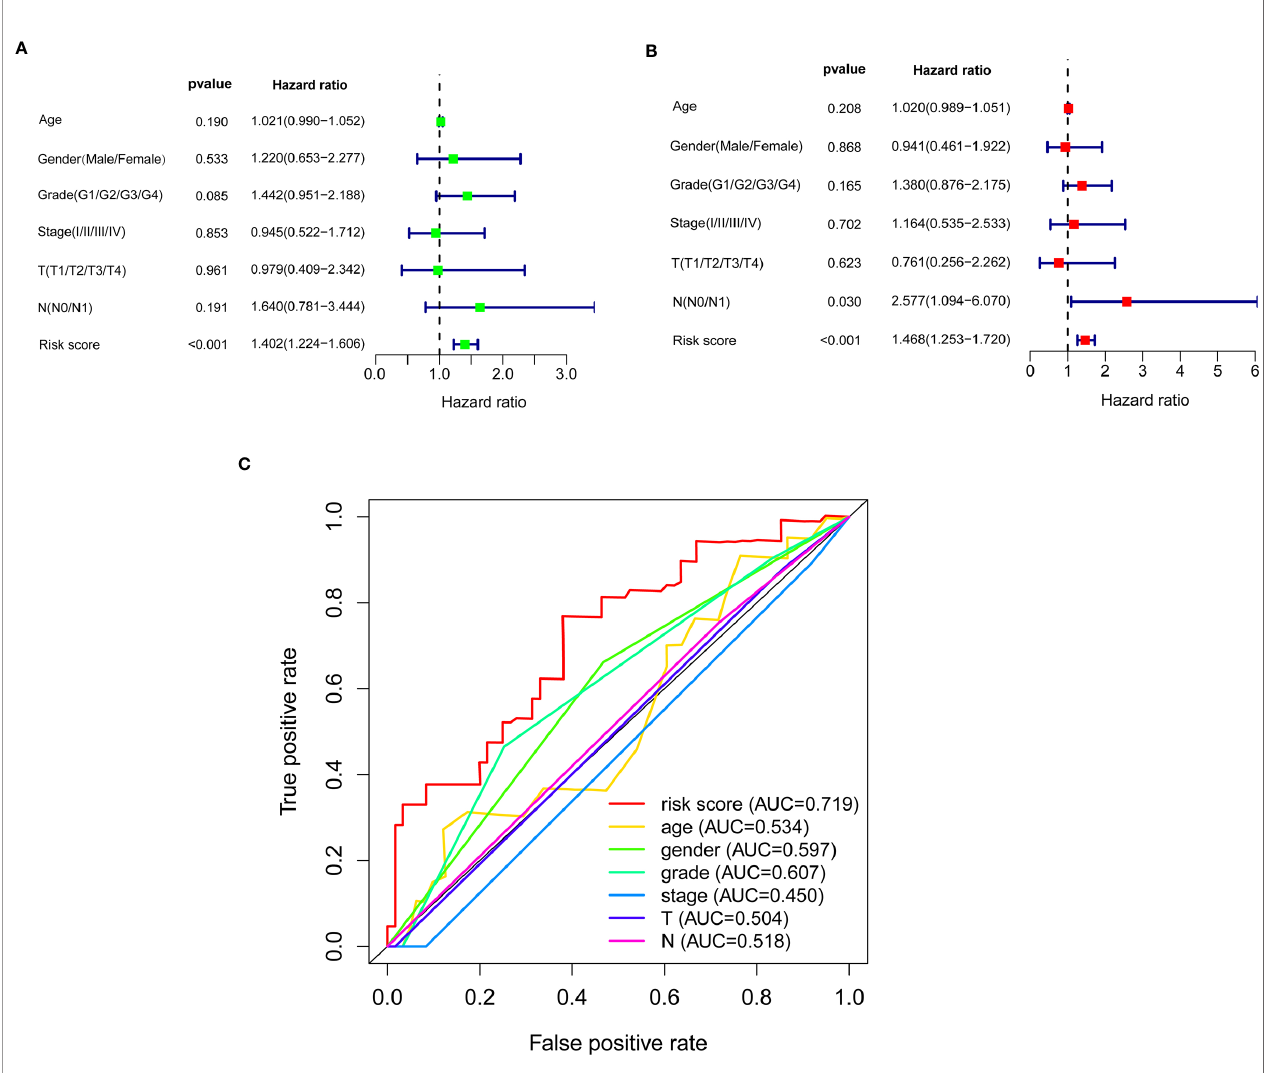
FIGURE 3 | Effects of the risk score and clinical information on the prognosis of PC patients. (A) To identify the relationship between the risk score or clinical information with OS by univariate Cox analyses. (B) To identify the relationship between the risk score or clinical information with OS by multivariate Cox analyses. (C) ROC curves analysis of OS for the prognosis risk score and the classical clinical